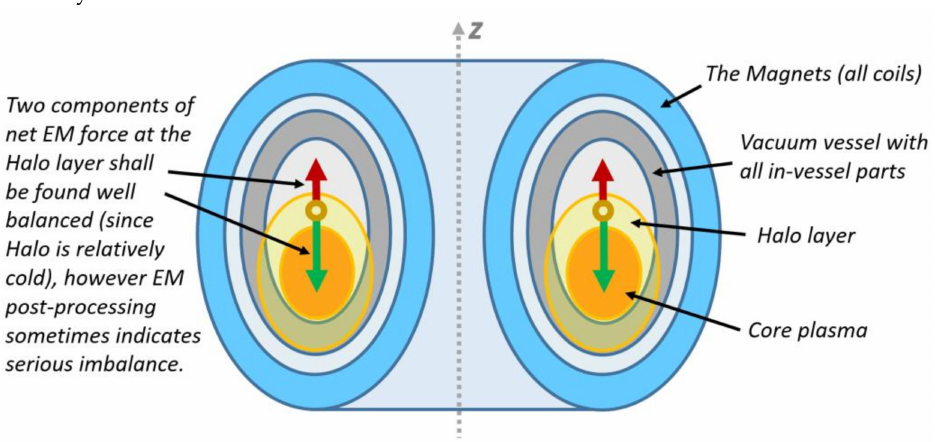
Figure 1. Green arrow: toroidal current component in the Halo layer interacts with toroidal currents in CS and PF coils, and with toroidal components of 3D currents in VV. This force pushes the Halo layer to the Core plasma. Red arrow: poloidal current component in the Halo layer interacts with currents in TF coils and with poloidal components of 3D currents in VV. This force pushes the Halo layer out of the Core plasma. In physical sense, these two components should almost compensate each other (the Halo layer shall be in MHD equilibrium); however, this is not always the case in numerical